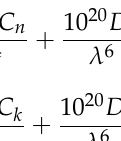
Figure 4. Refractive index ( a ) and extinction coefficient ( b ) fits to the Forouhi Bloomer model for the P3HT/G (1 wt%) nanocomposite. Experimental data are adapted from Ref. [9] with permission from the American Institute of Physics, 2012.